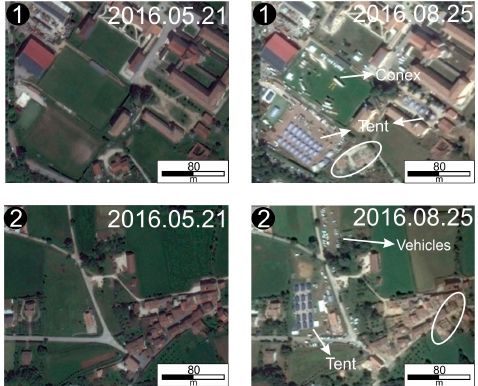
Figure 13. Optical images before the earthquake ( left ) and after the earthquake ( right ). See their location in Figure 9. White ovals indicate destroyed buildings. White arrows indicate man-made changes for temporary settlement of the affected people.